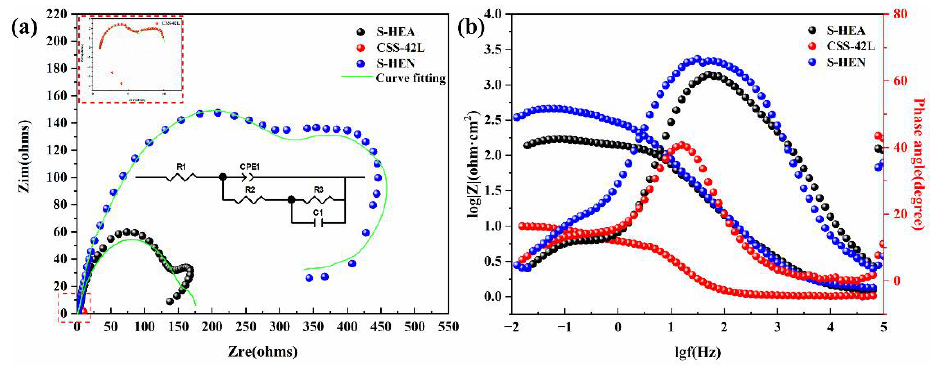
Figure 9. Electrochemical impedance spectroscopy of S-HEA/S-HEN films and CSS-42L steel in sulfuric acid: ( a ) Nyquist, ( b ) Bode. Table 4. The EIS parameters of the CSS-42L and S-HEA/S-HEN in 3.5% NaCl solution. Sample